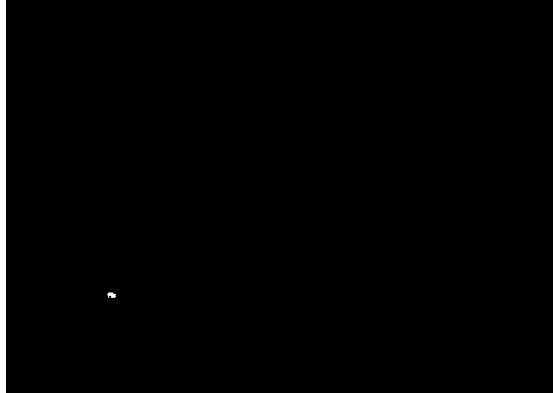
Figure 5. Ball position after filtering, extracted by using image moments.